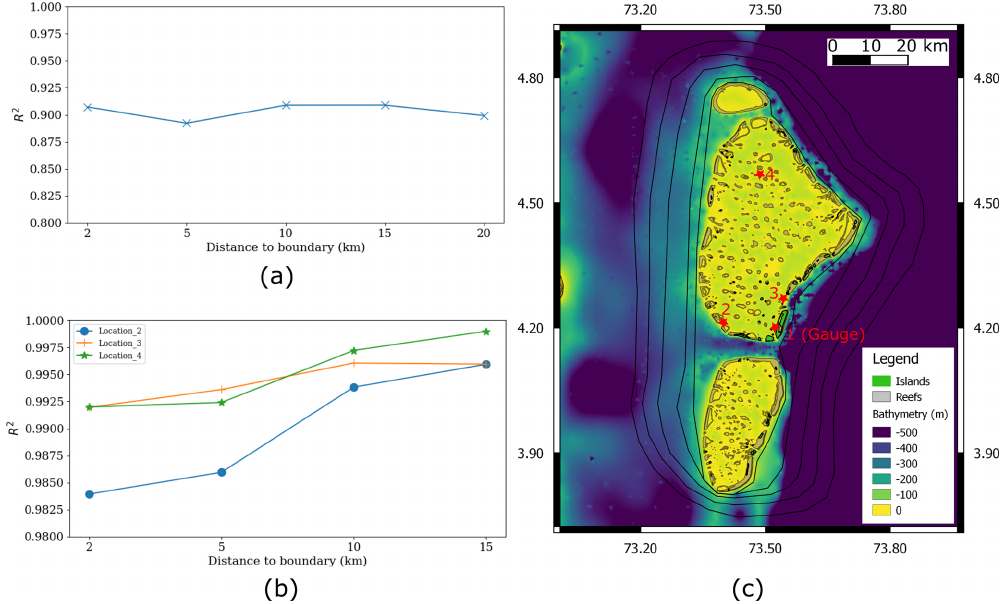
Figure 5. (a) Correlation between the simulation amplitudes and tide gauge data (at location 1 shown in c ) for domains with different minimum distances to the open boundary. (b) Correlation between tidal amplitudes at different locations (labelled 2–4 in c ) with varying distances to the boundary with tidal elevations obtained using the maximum boundary distance at 20km. (c) Visualisation of the different open-boundary locations used for the sensitivity study; the maximum westward boundary follows the 500m depth contour at the Maldives inner sea where possible. Locations where the elevations are compared are marked in red.